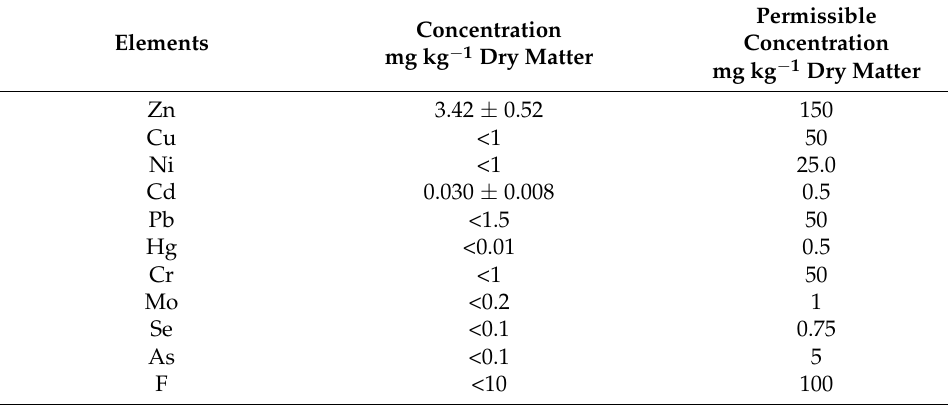
Table 3. Chemical analysis of the CUT 2 stem support